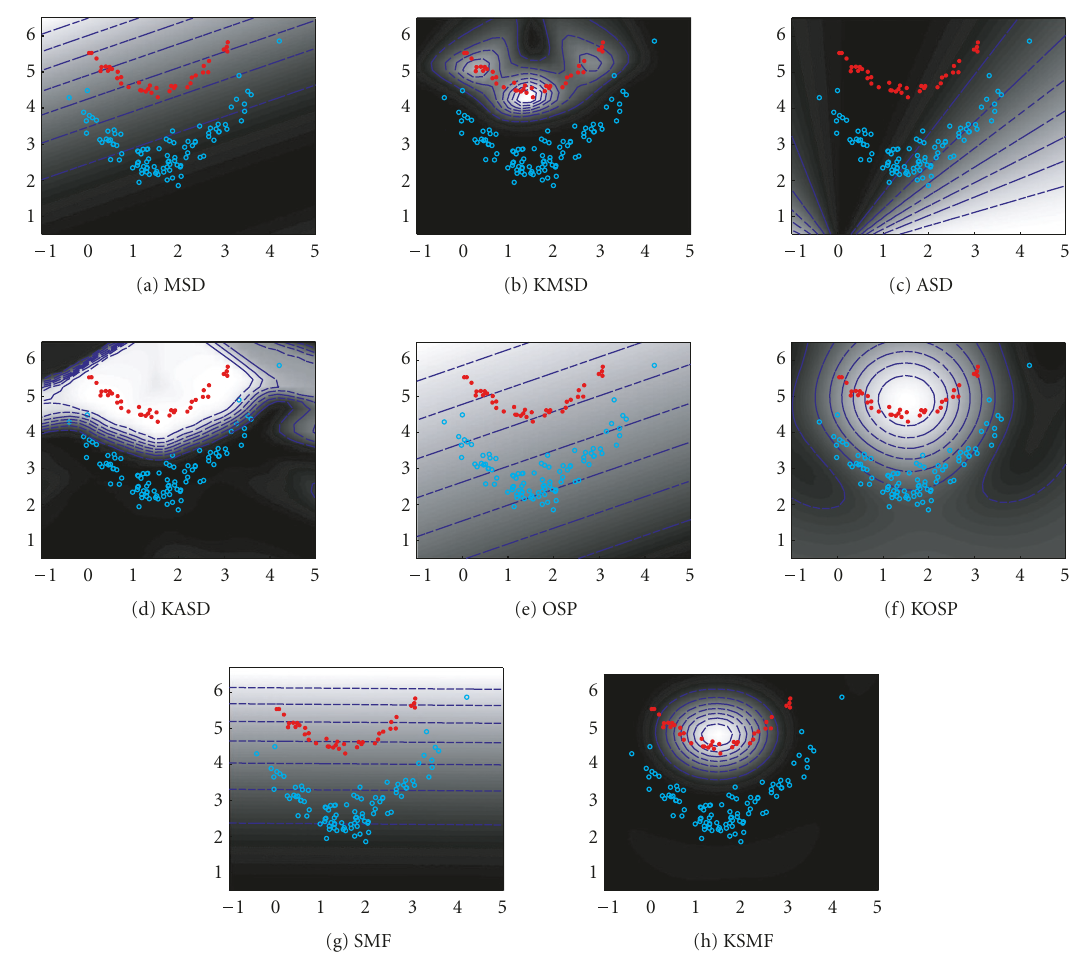
Figure 2: Contour and surface plots of the conventional matched signal detectors and their corresponding kernel versions on a toy dataset: in this toy example, the Gaussian mixture data shown in Figure 1 was modified to generate nonlinearly mixed data.